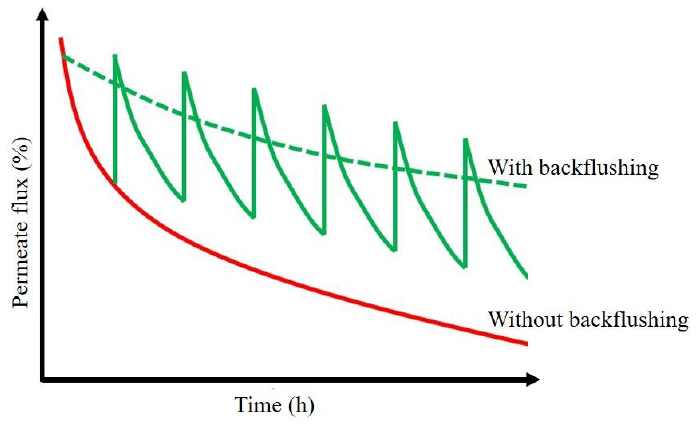
Figure 6. Effects of periodic back-flushings on permeate flux over time.